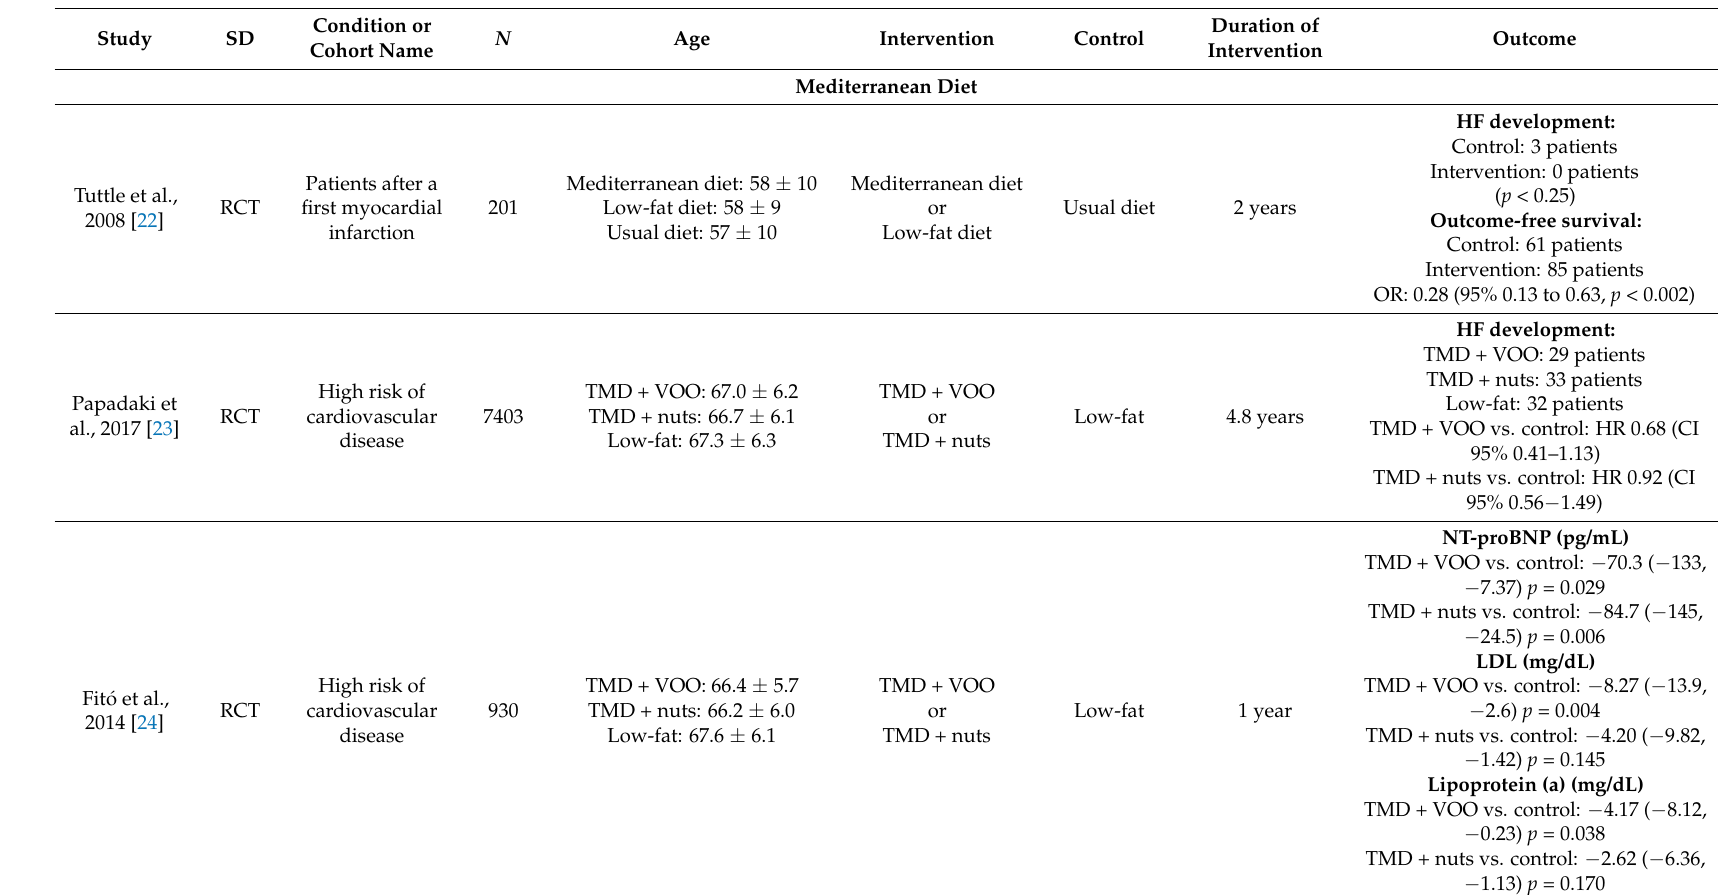
Table 1. Characteristics of